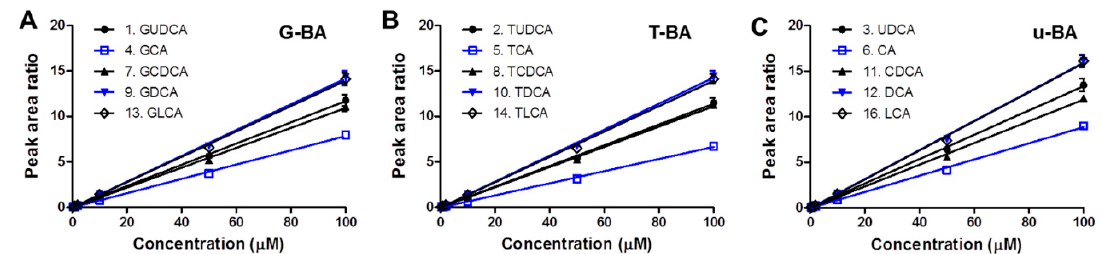
Figure 3. Calibration curve linearity of the standard bile acids. Calibration lines within the concentration range of 0.2–100 µM are displayed for ( A ) glycine-conjugated bile acids (G-BA compound No. 1, 4, 7, 9, 13), ( B ) taurine-conjugated bile acids (T-BA compound No. 2, 5, 8, 10, 14), and ( C ) unconjugated bile acids (u-BA compound No. 3, 6, 11, 12, 16).